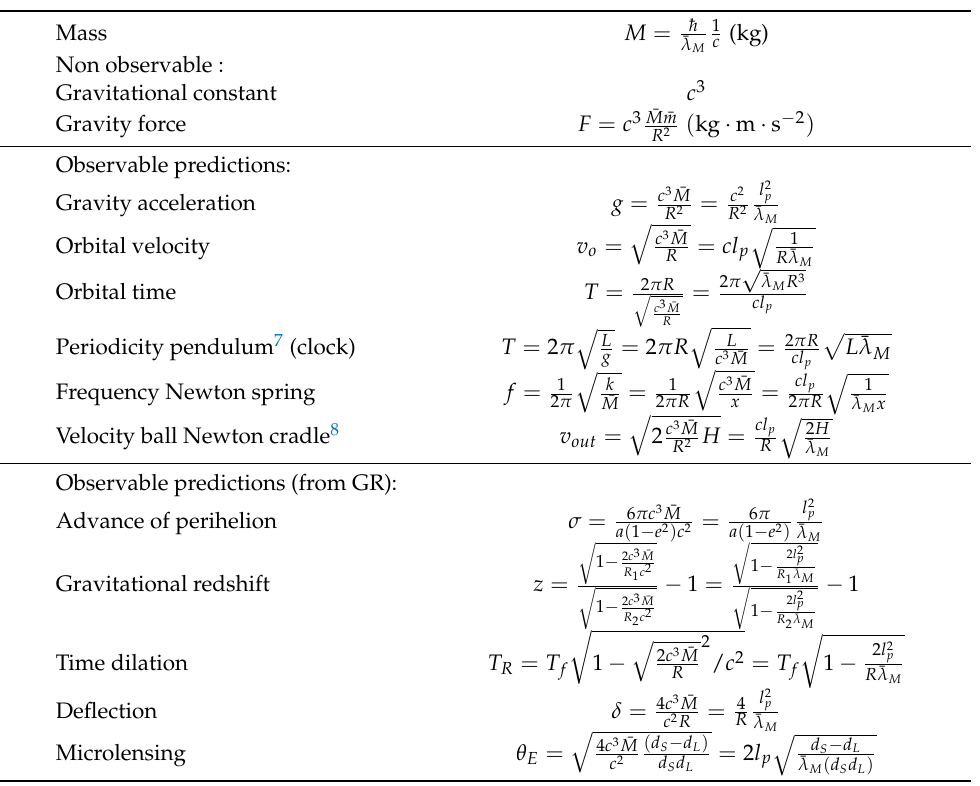
Table 5. The table shows that we can write the gravitational constant as c 3 when using, in our view, a l p more complete mass definition, ¯ m = l p ¯ λ . That is, mass is related to time, or what Haug has called c collision-time. Different mass sizes then only differ in different Compton wavelengths. Writing the gravitational force formula this way yields the same predictions as standard Newton gravity except we only rely on two constants, l p and c , to describe mass and any observable gravity phenomena. In addition, in general relativity predictions, we can replace the mass with this mass definition if we replace G with c 3 . The reason we can do this is that c 3 ¯ M = GM . This is clear when we understand that G is a composite constant and, in addition, understand that the kilogram mass can be written by simply solving the Compton wavelength formula with respect to m